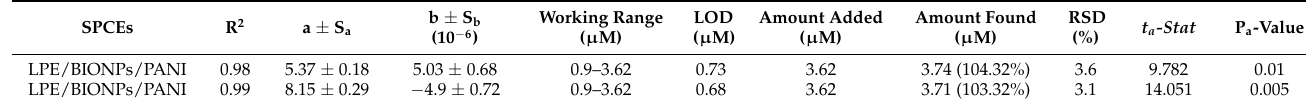
± S b Working Range LOD Amount Added Amount Found RSD t a -Stat P a -Value (10 − 6 ) ( µ M) ( µ M) ( µ M) ( µ M) (%)